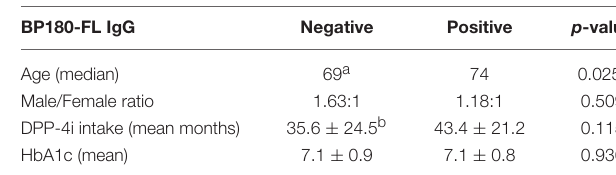
TABLE 2 | Comparison of age, male/female ratio, DPP-4i intake period, and HbA1c for anti-full-length BP180 IgG autoantibody-positive and -negative cases in the DPP-4i ( + )